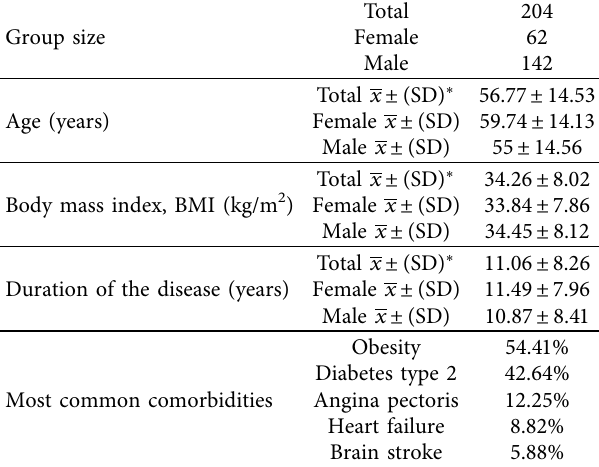
Table 1: General characteristics of hospitalized patients with ar- terial hypertension ( n �